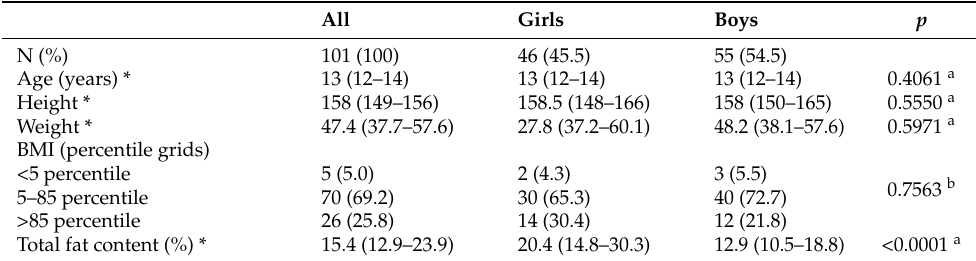
Table 1. Characteristics of the study sample (anthropometric data).